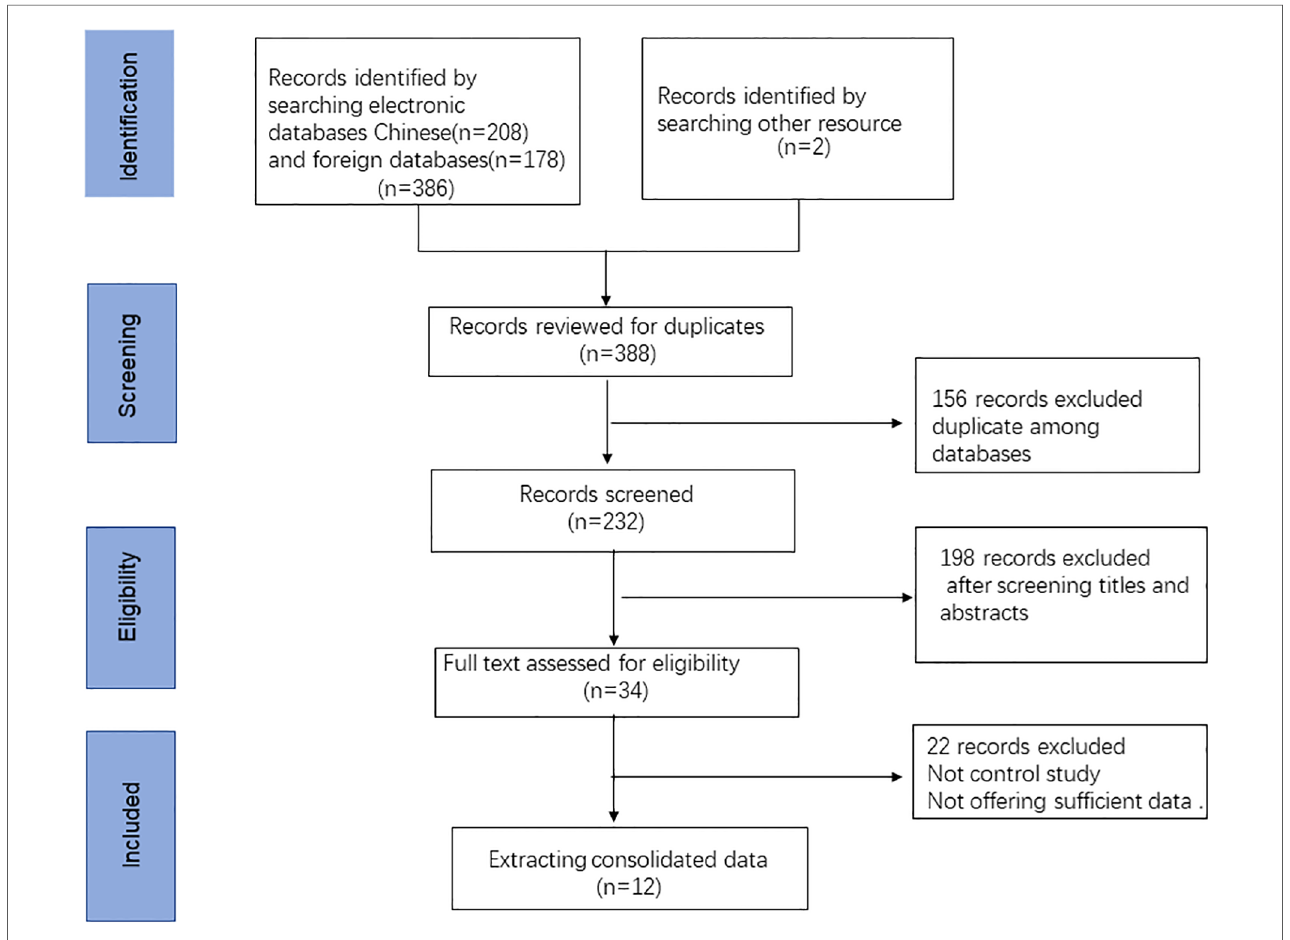
FIGURE 1 A fl ow diagram demonstrating the study selection